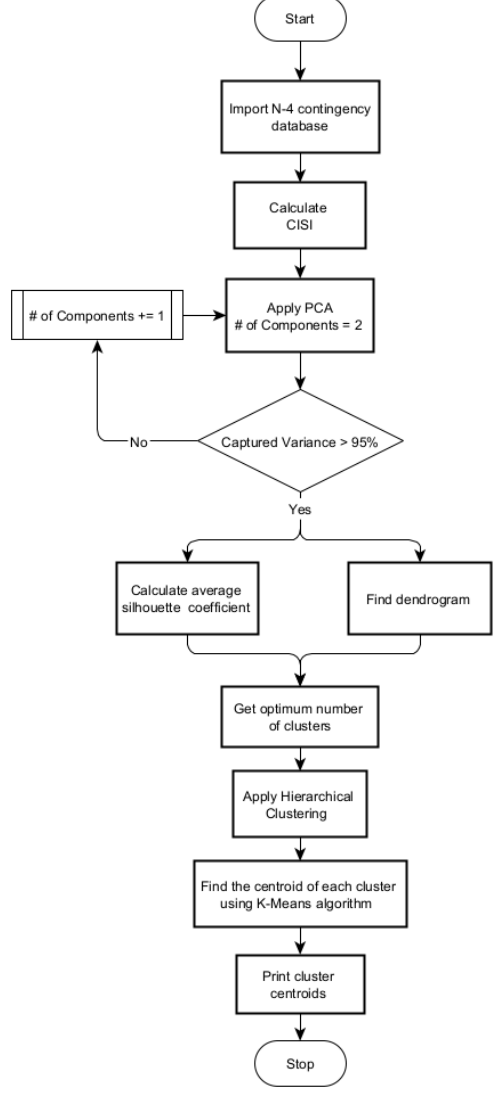
Figure 1. The procedure followed for power system contingency screening and ranking.